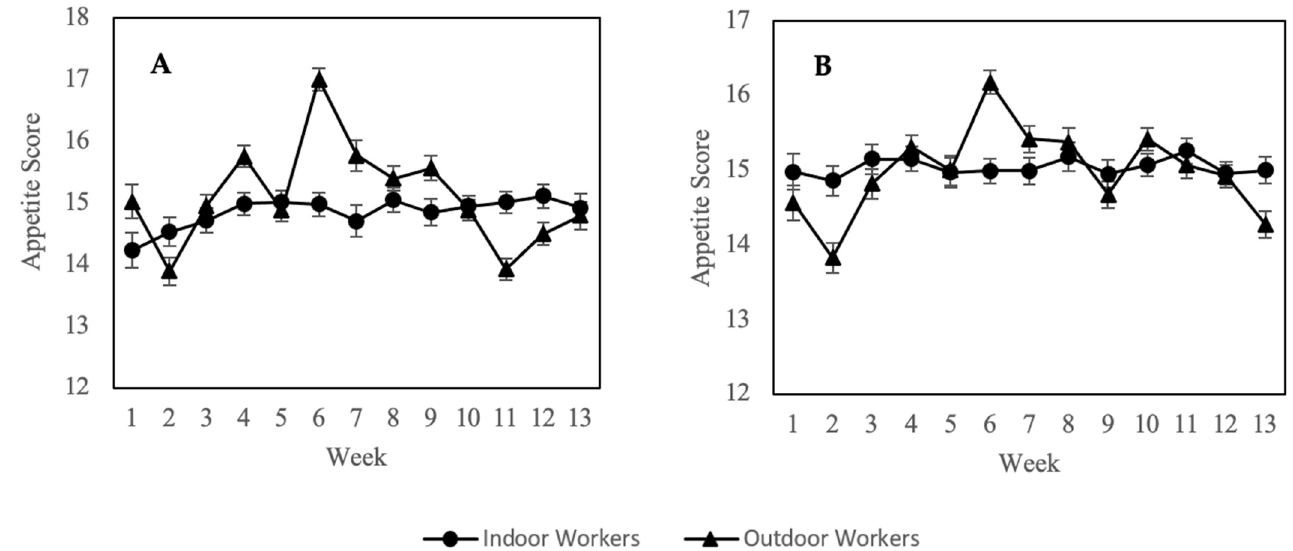
Figure 2. Change of mean appetite scores between indoor and outdoor workers over 13 weeks pe- riod in Cycle 1 ( A ) and Cycle 2 ( B ). Values are expressed as means ± standard error. Table 2. Pearson Correlation Coefficient Matrix of the Measured Variables. PM 2.5 Concentration Variables Cycle 1 Cycle 2 Indoor Appetite Indoor Workers Appetite